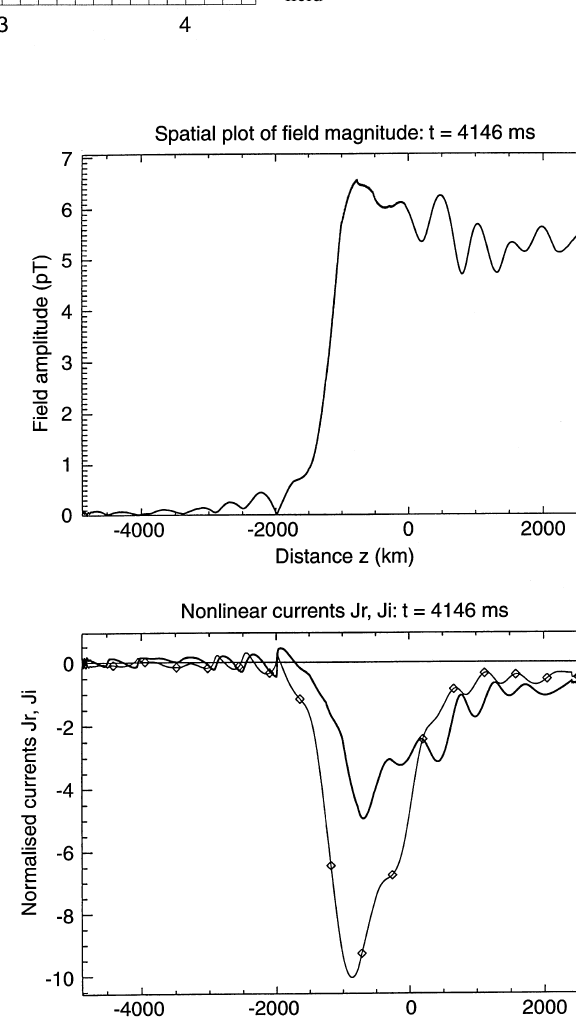
Fig. 19. Case D. Upward hook. Frequency/time diagram of exit wave field